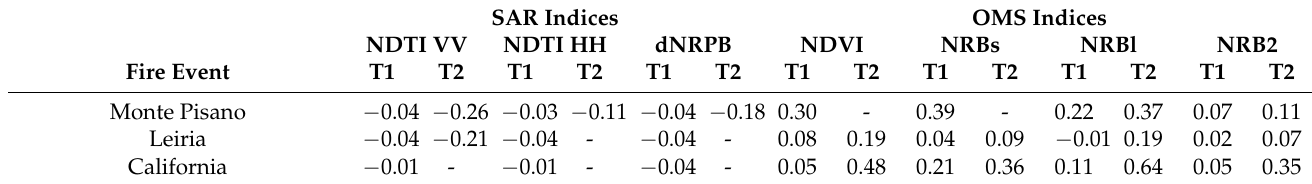
Table 6. Index-differencing thresholds of both SAR and OMS indices, for burned-related changes. SAR